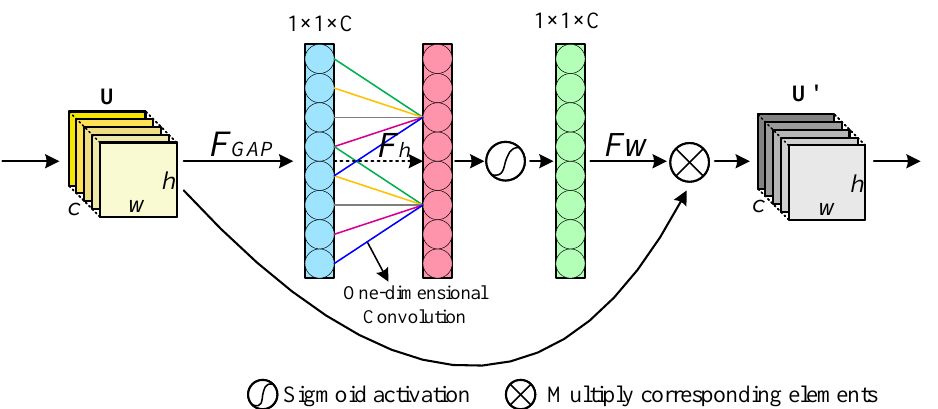
Figure 8. Lightweight adaptive attention